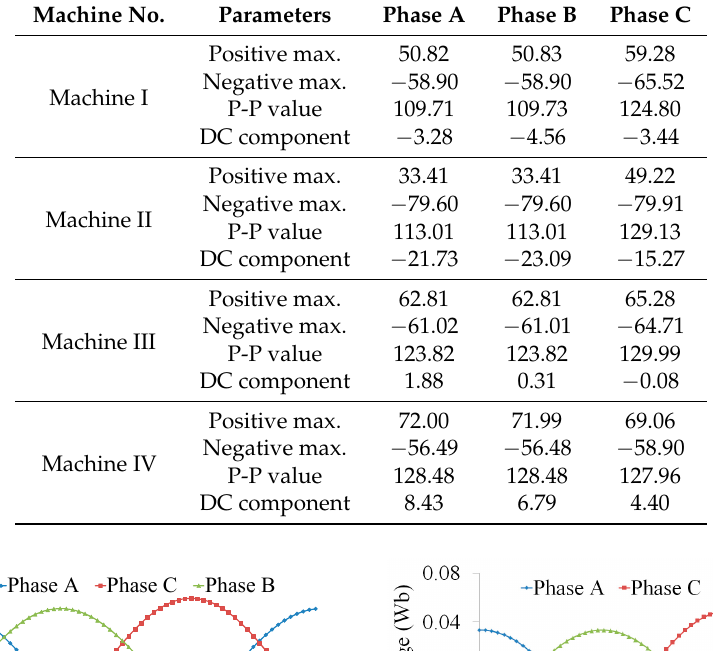
Table 3. No-load flux linkage values (mWb).